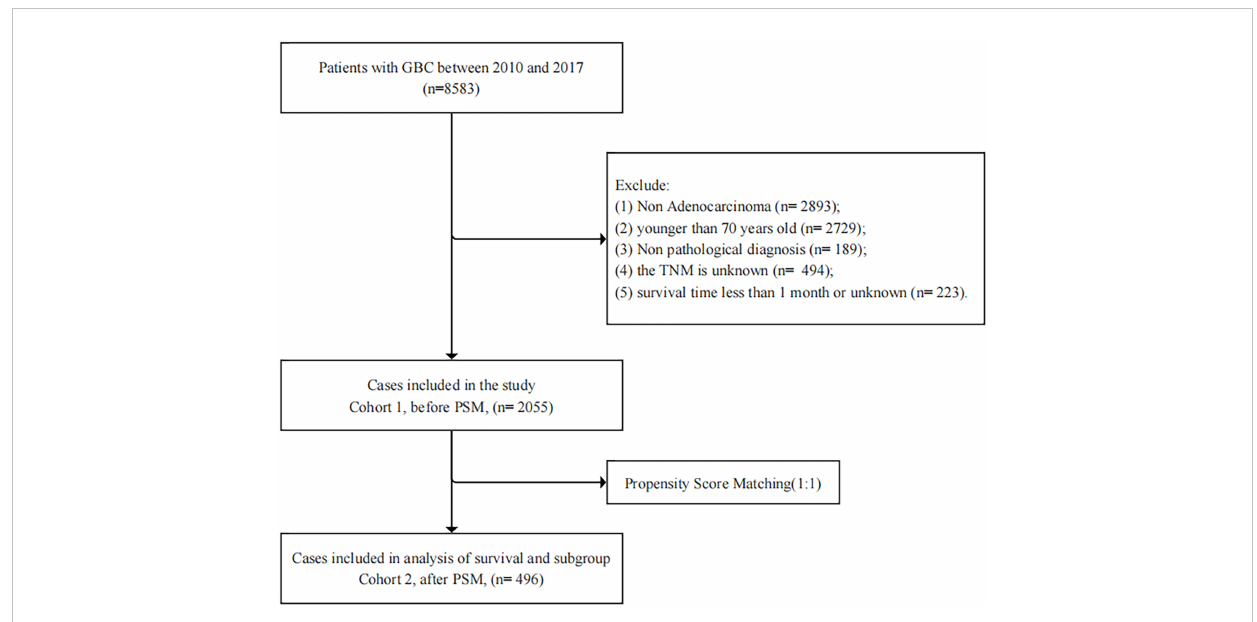
FIGURE 1 Enrollment fl ow chart of eligible patients in the present